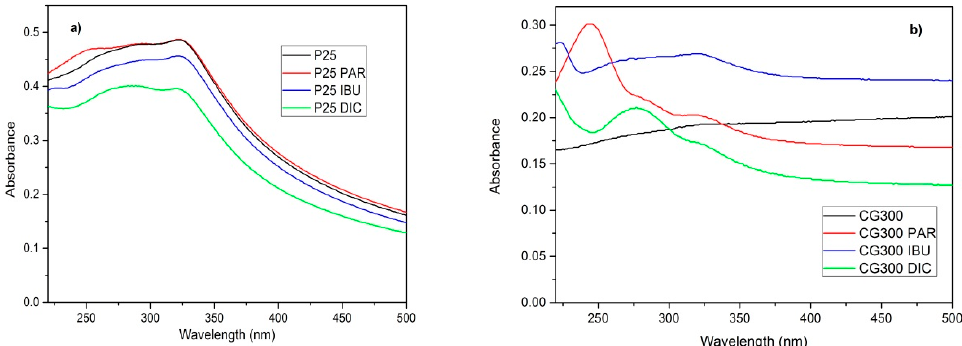
Figure 7. Absorption spectra of suspensions of P25 ( a ) and CG300 ( b ) and pharmaceuticals before photocatalytic